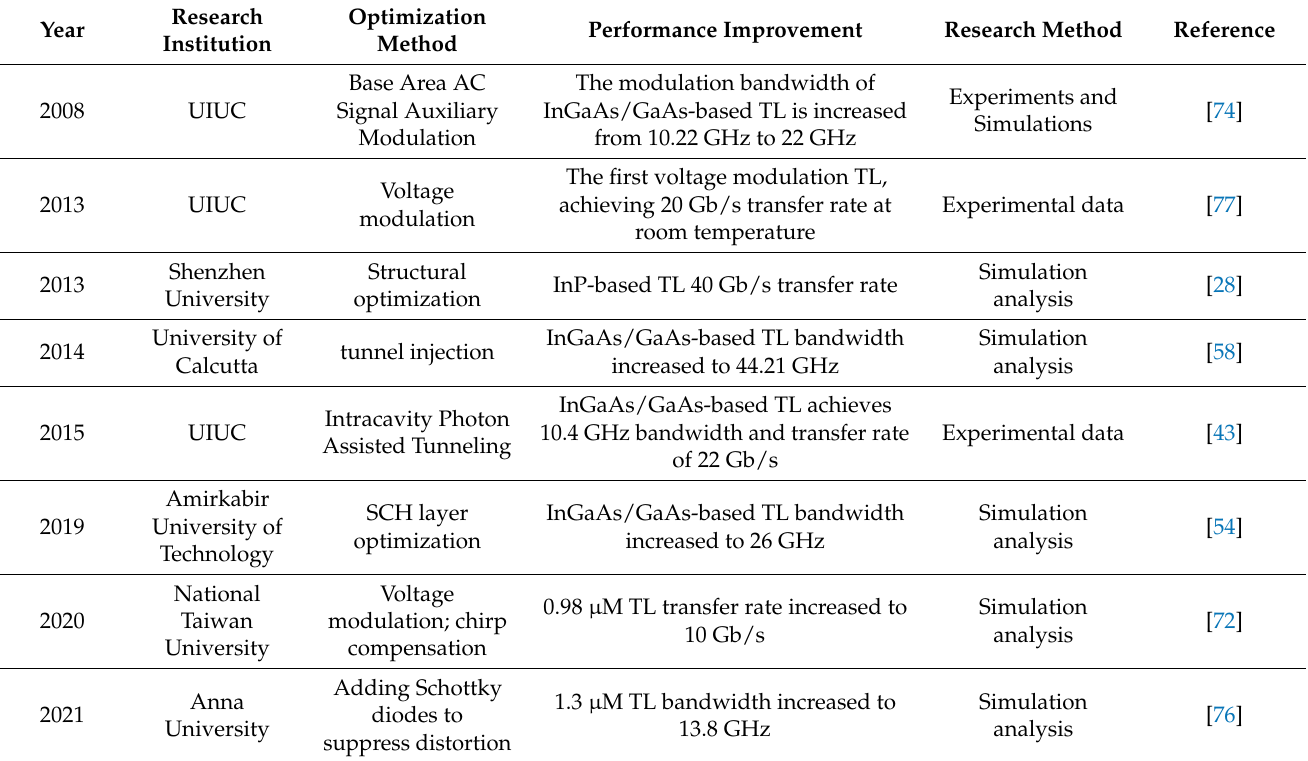
Table 1. Development of TL modulation characteristics in the past